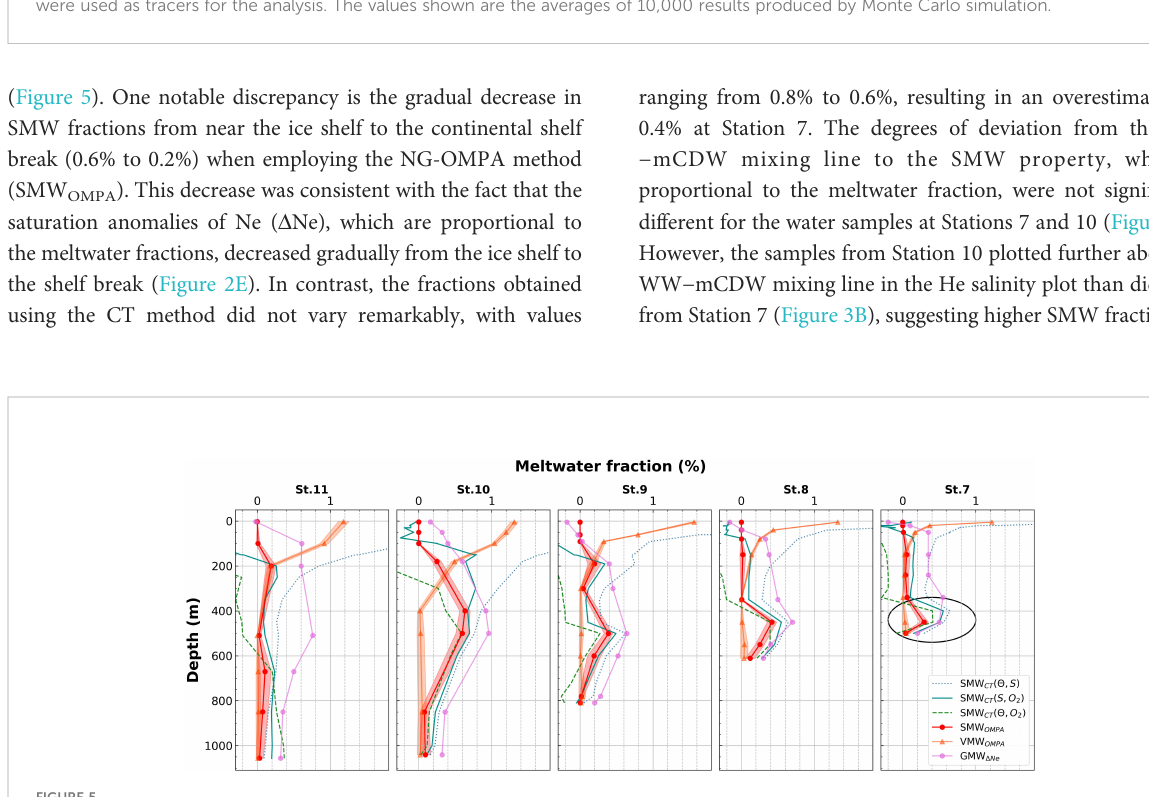
FIGURE 5 Comparison of SMW fractions calculated by the NG-OMPA and CT methods. Red lines and shaded areas show the averages and the uncertainties of NG-OMPA method. The uncertainties are one standard deviation of 10,000 fractions calculated by Monte Carlo simulation with perturbed values. SMW fractions calculated by the CT method with different pairs of tracers are shown as teal lines. The circle at the bottom of Station 7 highlights a large discrepancy between the SMW fractions estimated by the NG-OMPA and CT methods. Given the lower D He and D Ne at Station 7 (Figure 2), compared with those at Station 10, it is likely that the SMW fraction at Station 7 is lower than that at Station 10. The fractions of ventilated SMW (VMW) calculated by the NG-OMPA are shown as orange lines. The fractions of glacial meltwater derived from excess Ne are depicted as purple